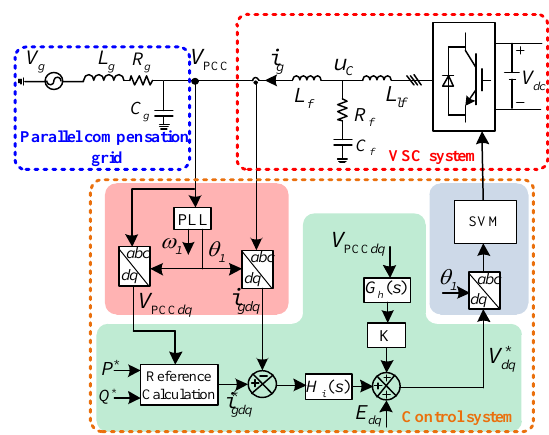
Figure 6. Implementation of VSC system with the proposed voltage feedforward control.